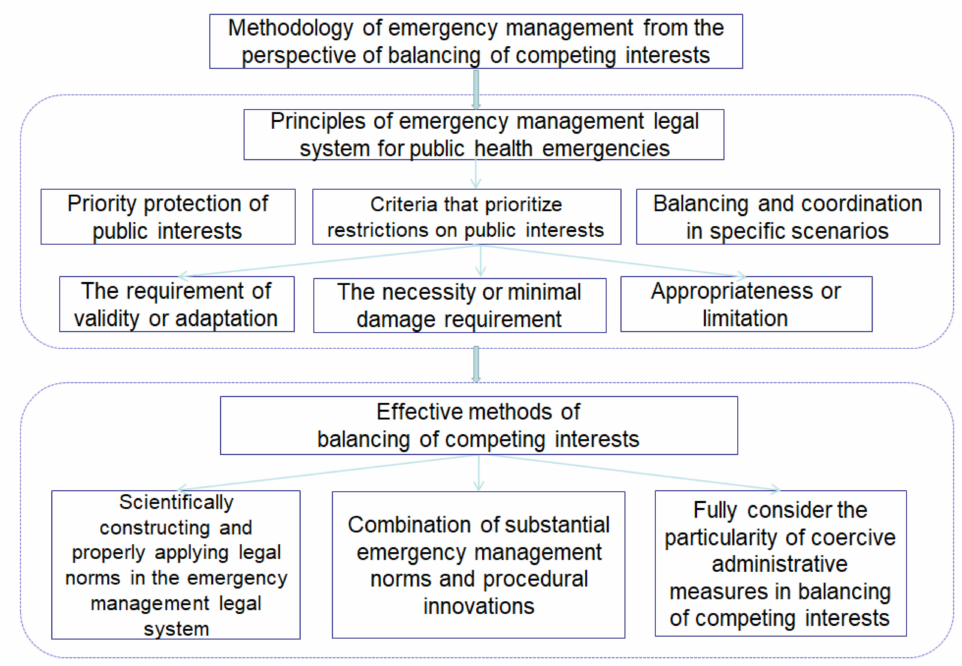
Figure 3. Methodology of emergency management from the perspective of balancing competing